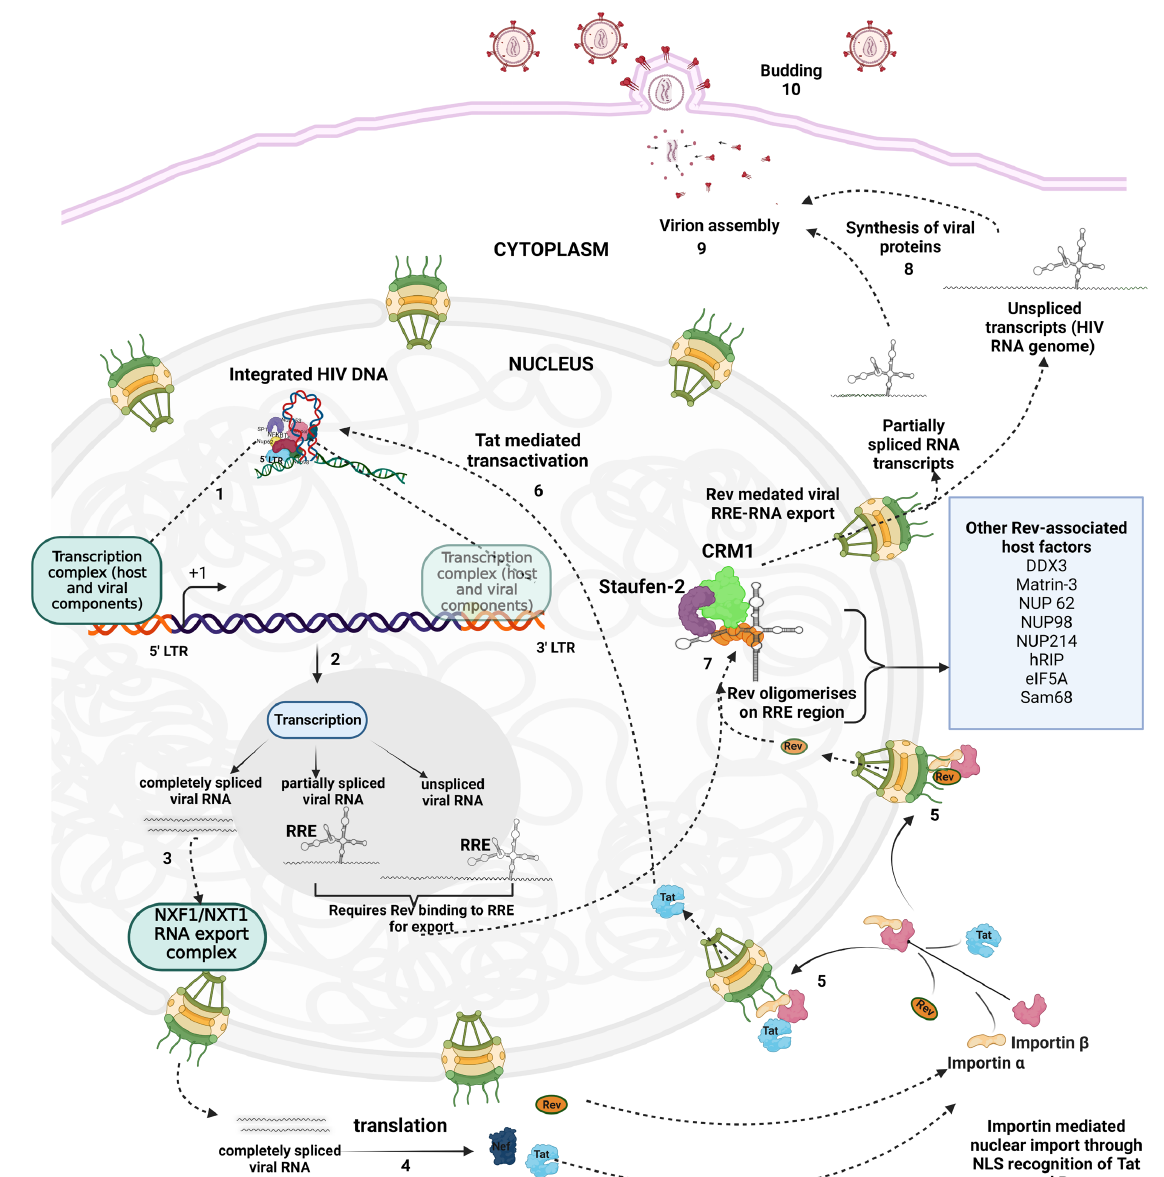
Figure 2. Schematic representation of events depicting post-integration events during HIV-1 infection, representing some of the crosstalk of viral components with nuclear trafficking machinery. The integrated viral DNA (1) at the sites of euchromatic regions is transcribed by the host transcription machinery; some of the experimentally demonstrated proviral DNA binding proteins are listed in the Table 1. Transcription leads to the generation of three kinds of viral mRNA, unspliced, partially spliced, and completely spliced (2). The completely spliced viral transcripts are exported by the host NXT1/NXF1 system (3). The viral proteins Rev, Tat, and Nef are generated upon translation of the completely spliced RNA (4). Rev and Tat are imported into the nucleus through importin α / β complex by their NLS signal sequence (5). Tat translocates into the nucleus and causes transactivation of viral LTR promoter (6), Rev binds to Rev responsive elements (RRE) present in the partially spliced and unspliced viral RNAs and interacts with several host RNA export factors (listed in the box) and mediates transport of RRE containing viral RNA into the cytoplasm (7). The partially spliced and unspliced RNAs translate different structural and regulatory proteins (8) and are assembled into the viral core along with two copies of the RNA genome (unspliced viral RNA) (9). The assembled virions bud out of the cell